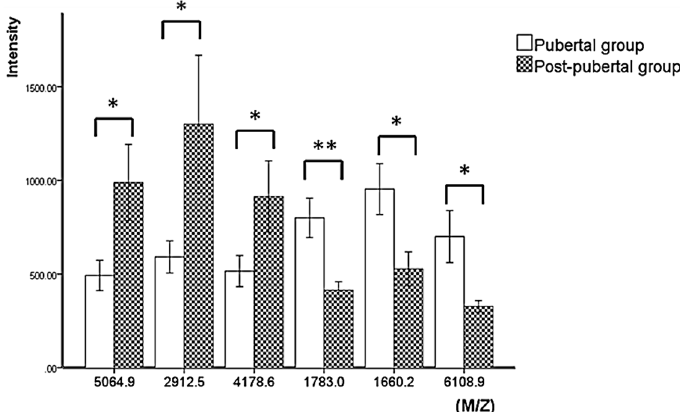
Figure 2. Column view of differential expressed protein peaks between pubertal and post-pubertal groups. Three peptides are upregulated, and three peptides are downregulated from the pubertal group to the post-pubertal group. (* p < 0.05, ** p < 0.01).